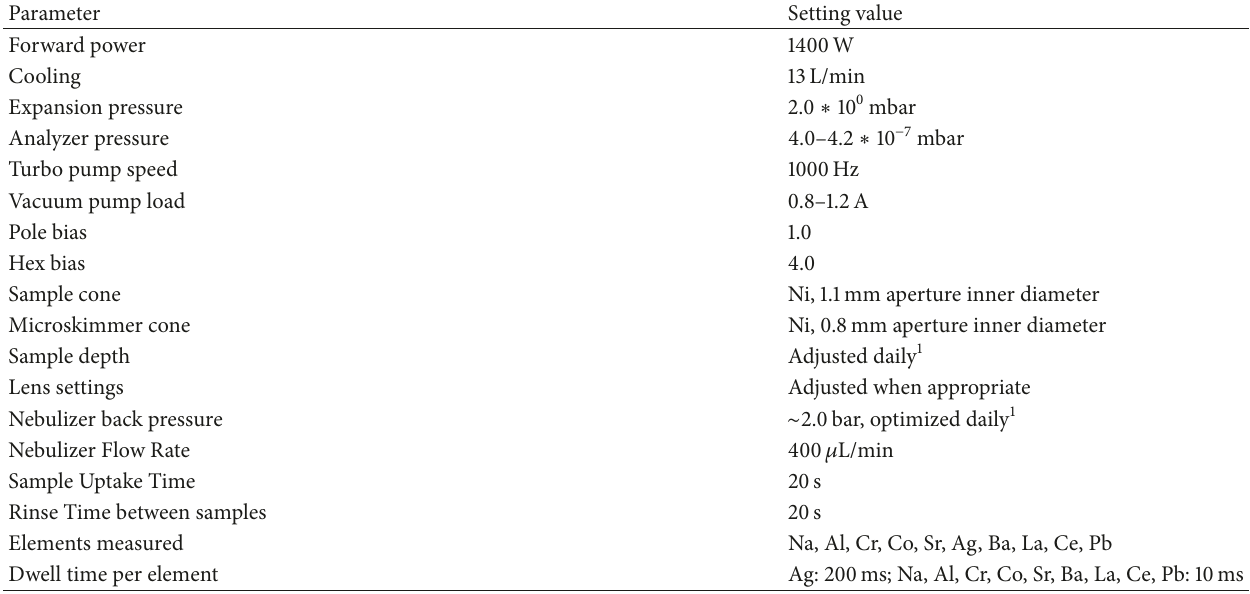
Table 1: Operating ICP-MS conditions and acquisition parameters.